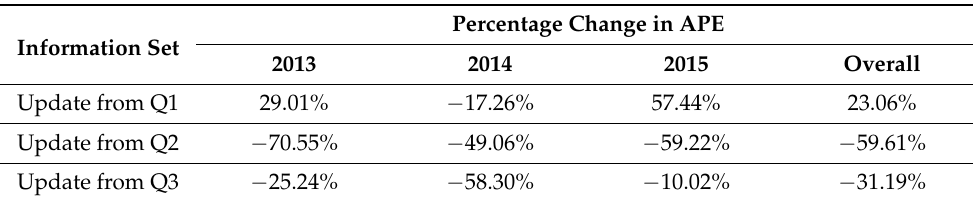
Table 5. Effects of quarterly updates relative to the forecast based on the time series of quarterly data up to the immediately previous quarter’s quarterly